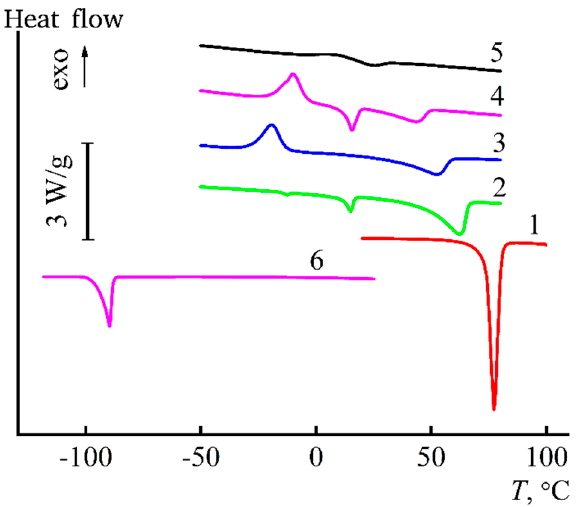
Figure 5. Thermograms of the solvent-coagulant mixtures of the following NMMO/IPA (mass %) composition: (1) 100/0; (2) 87/13; (3) 81/19; (4) 72/28; (5) 58/42; and (6) 0/100.